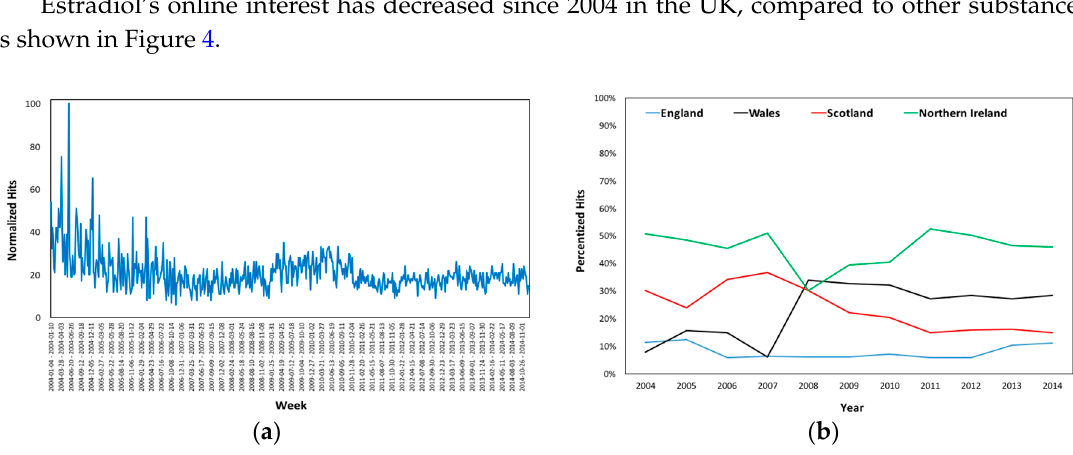
Figure 4. Estradiol’s ( a ) Normalized Hits in the UK and ( b ) Regional Percentized Hits Averages 2004–2014.